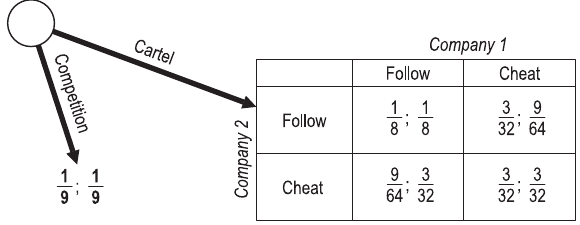
Fig. 1. The cheater‘s game